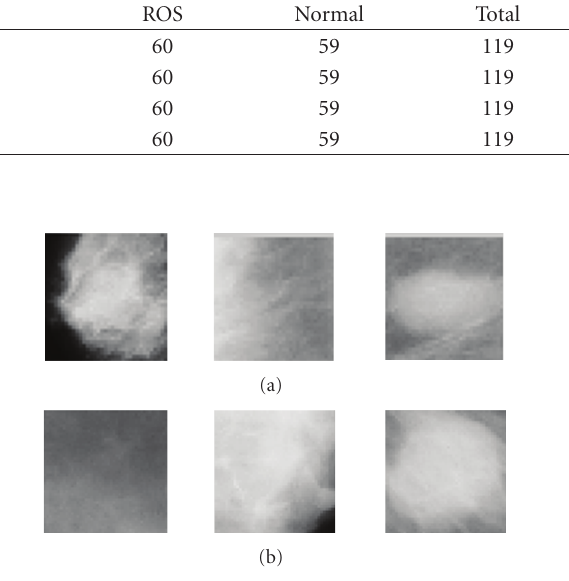
Figure 2: (a) Benign, normal, and malignant subimages of size 35 × 35 pixels and (b) benign, normal, and malignant subimages of size 45 × 45